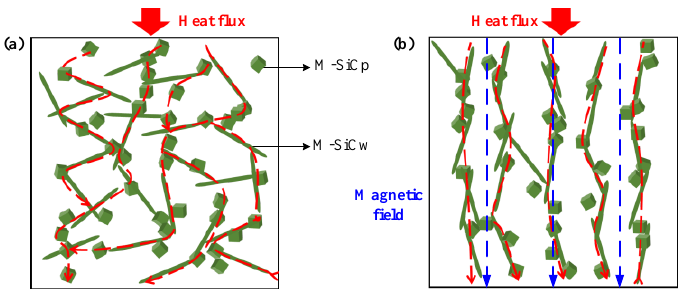
Figure 13. Schematic diagram of heat conduction inside M-SiC/EP composites. ( a ) Randomly oriented M-SiC/EP-N; ( b ) orderly oriented M-SiC/EP-C.